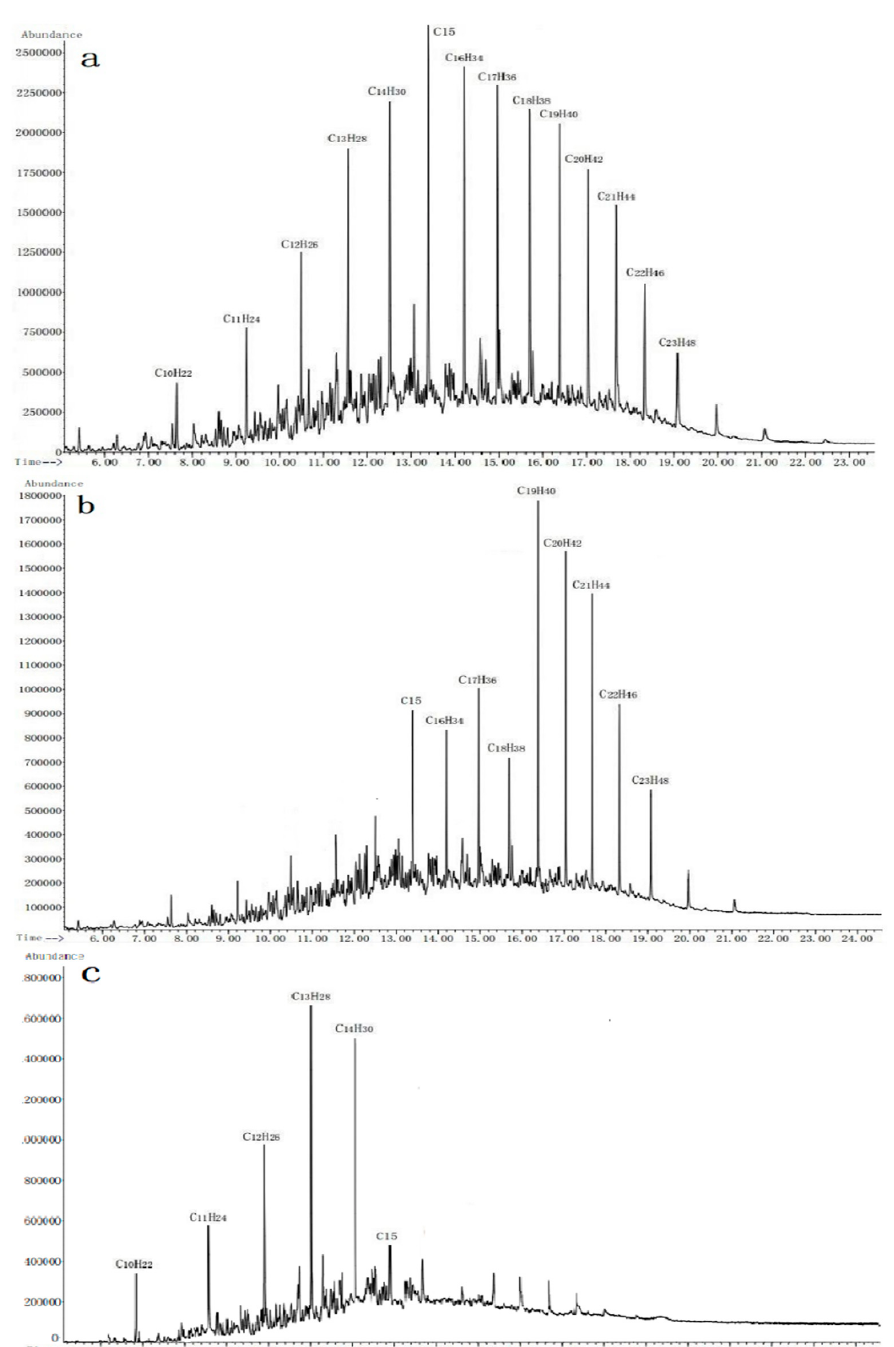
Figure 2. GC-MS spectra of diesel constituents in the absence and presence of Kp and Pa. ( a ) original 1.5% diesel sample; ( b ) culture medium after 8-day degradation by Kp; and ( c ) culture medium after 8-day degradation by Pa.